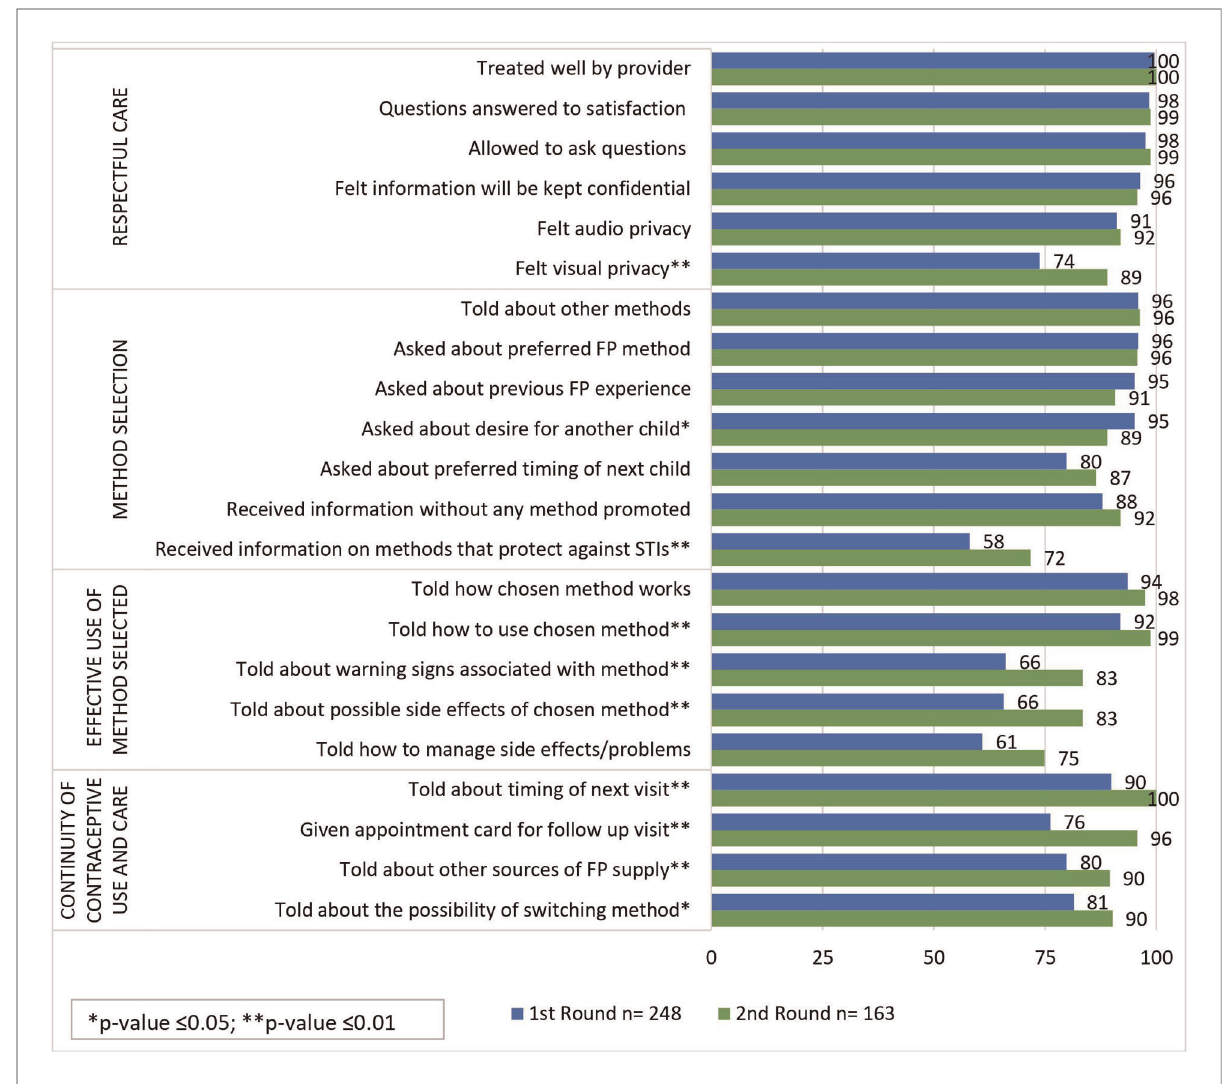
FIGURE 1 Percentage of women reporting quality of care received from CPs and PPMVs in Lagos by domain and round ( n